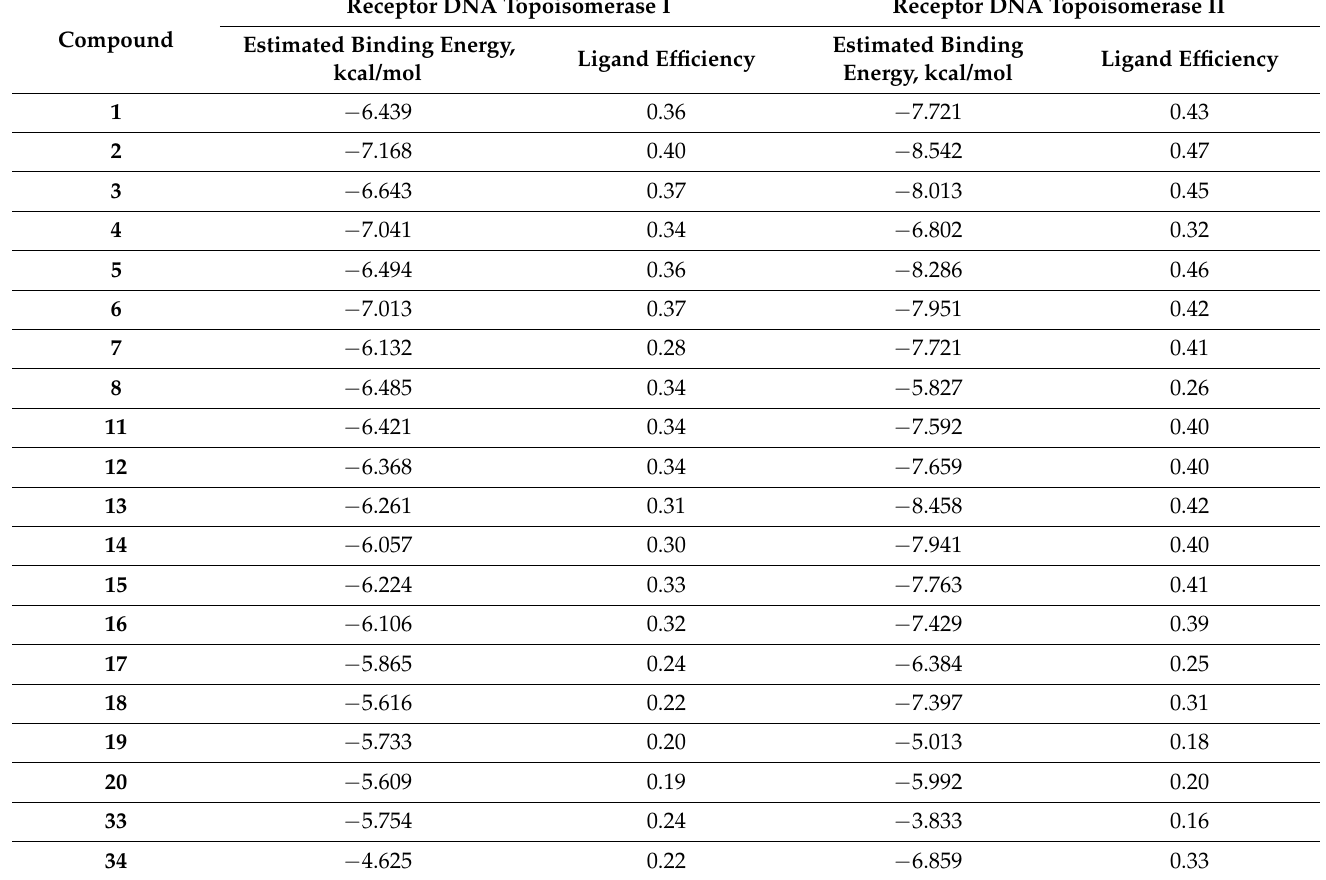
Table 5. Ligand efficiency and values of the estimated binding energy of the complexes of the studied compounds with the receptors DNA topoisomerase I and DNA topoisomerase